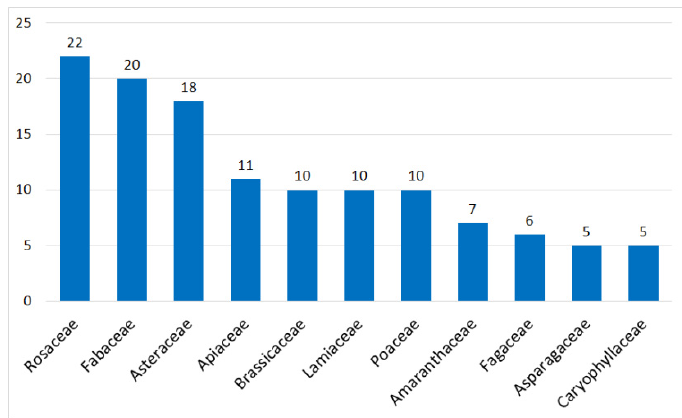
Figure 1. Families represented by more than five species for the 198 certain species.